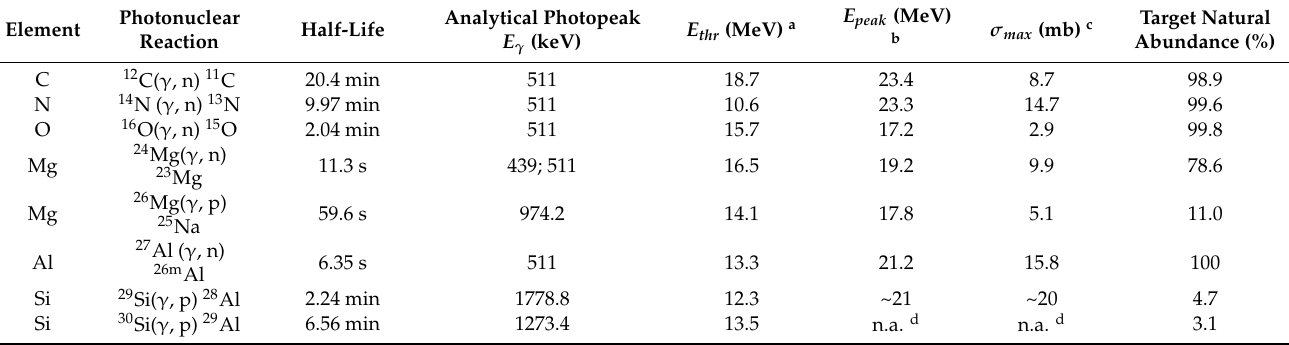
Table 1. Radionuclides and photonuclear reactions considered in application of the short-time irradiation for geochemical analysis